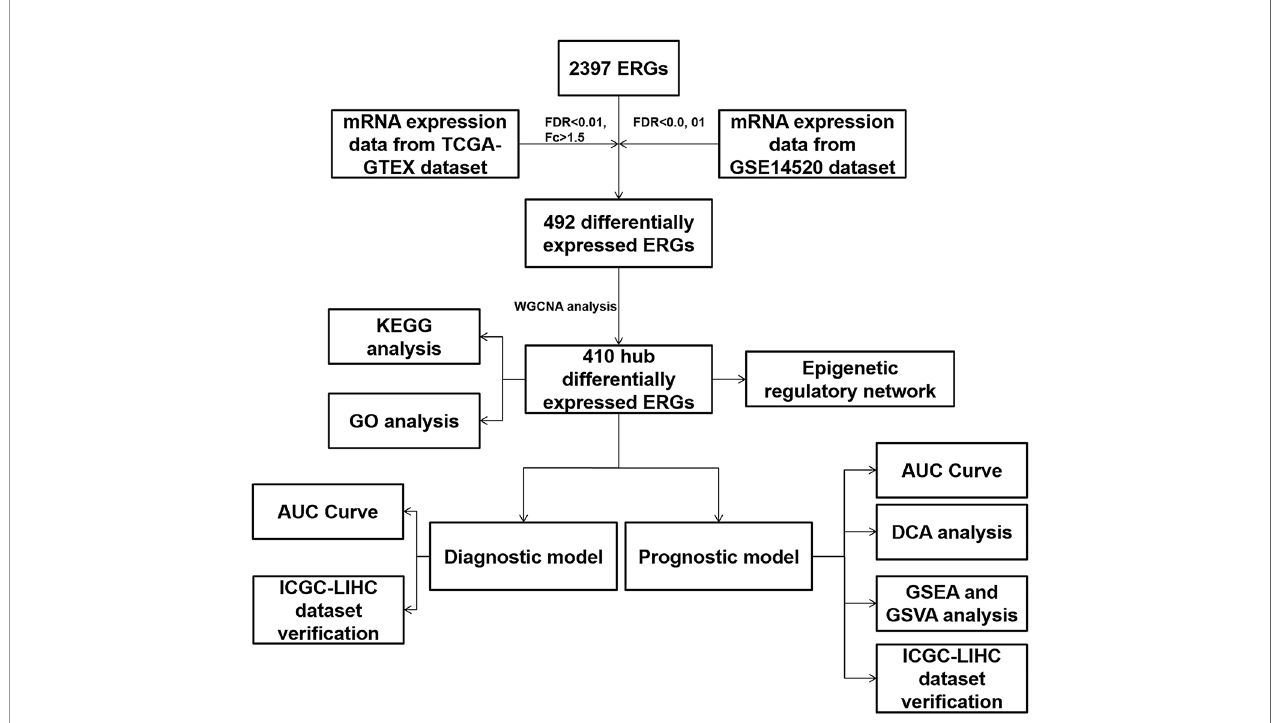
FIGURE 1 | Analysis fl owchart of the